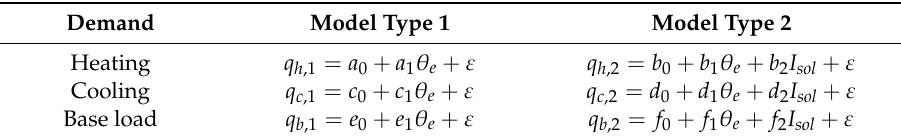
Table 3. Regression models for heating, cooling and baseline demand